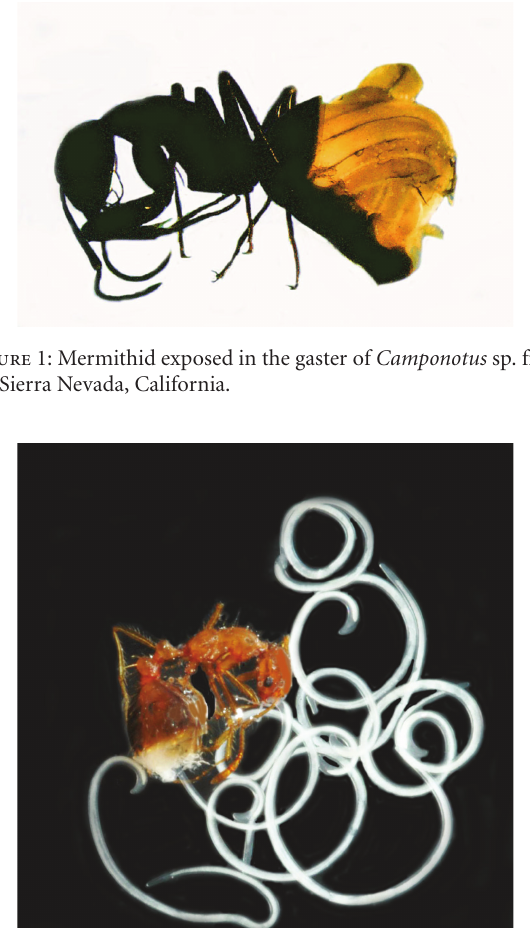
Table 1: Section from Gould [2] referring to the first reported instance of mermithid parasitism of ants.